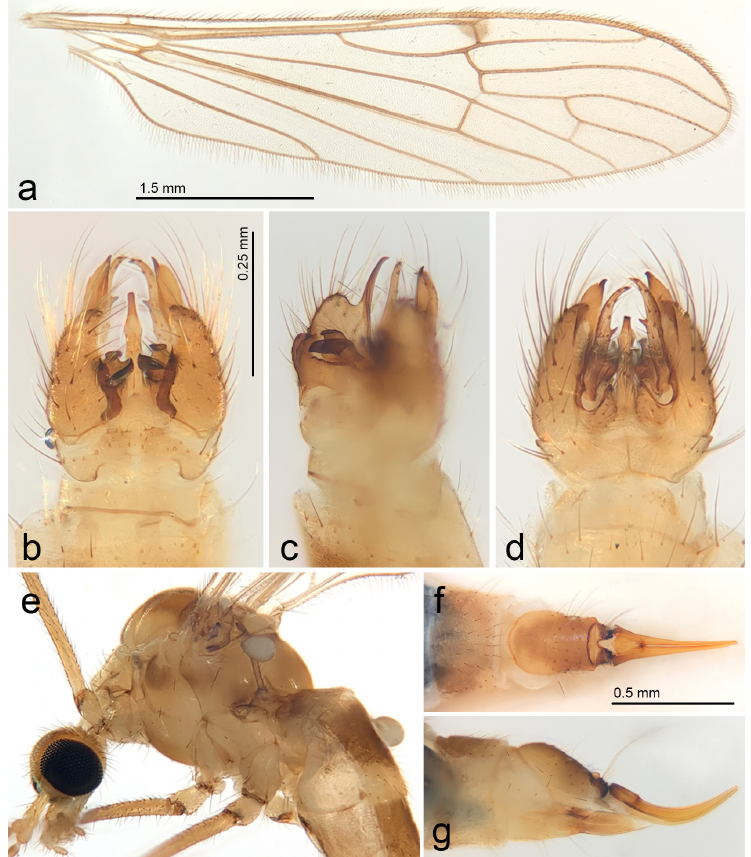
Figure 2. Teucholabis (Teucholabis) carbetensis sp. nov., holotype male; ( a ) Right wing; ( b ) Hypopygium in dorsal view; ( c ) idem in semi-lateral view; ( d ) idem in ventral view; ( e ) Head and thorax, lateral view; ( f ) Paratype female, ovipositor in dorsal view; ( g ) idem in lateral view.